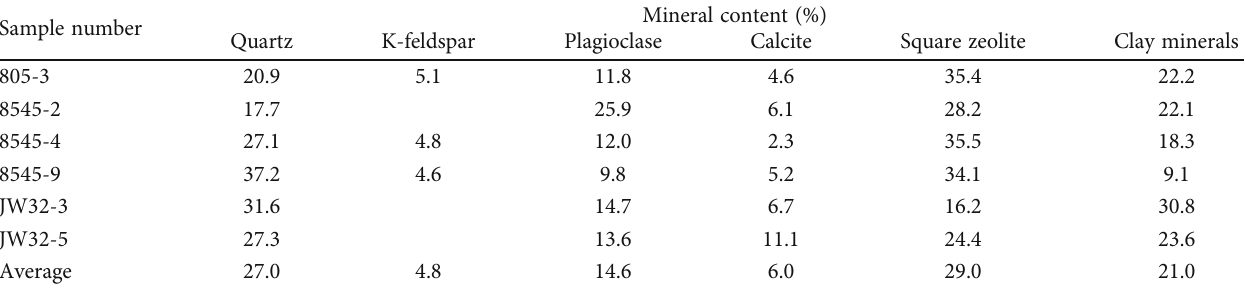
Table 2: Mineral composition of interlayer cores.